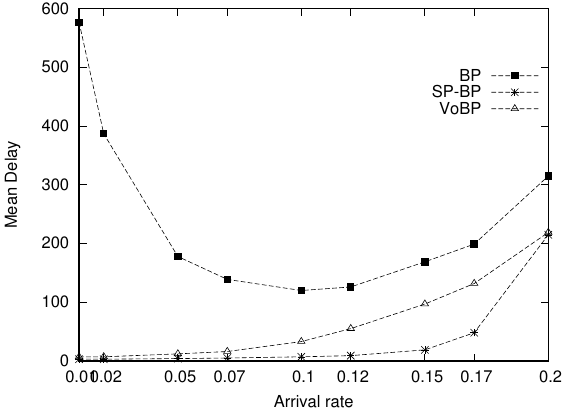
Figure 1. Performance of VoBP in a 12-node ring